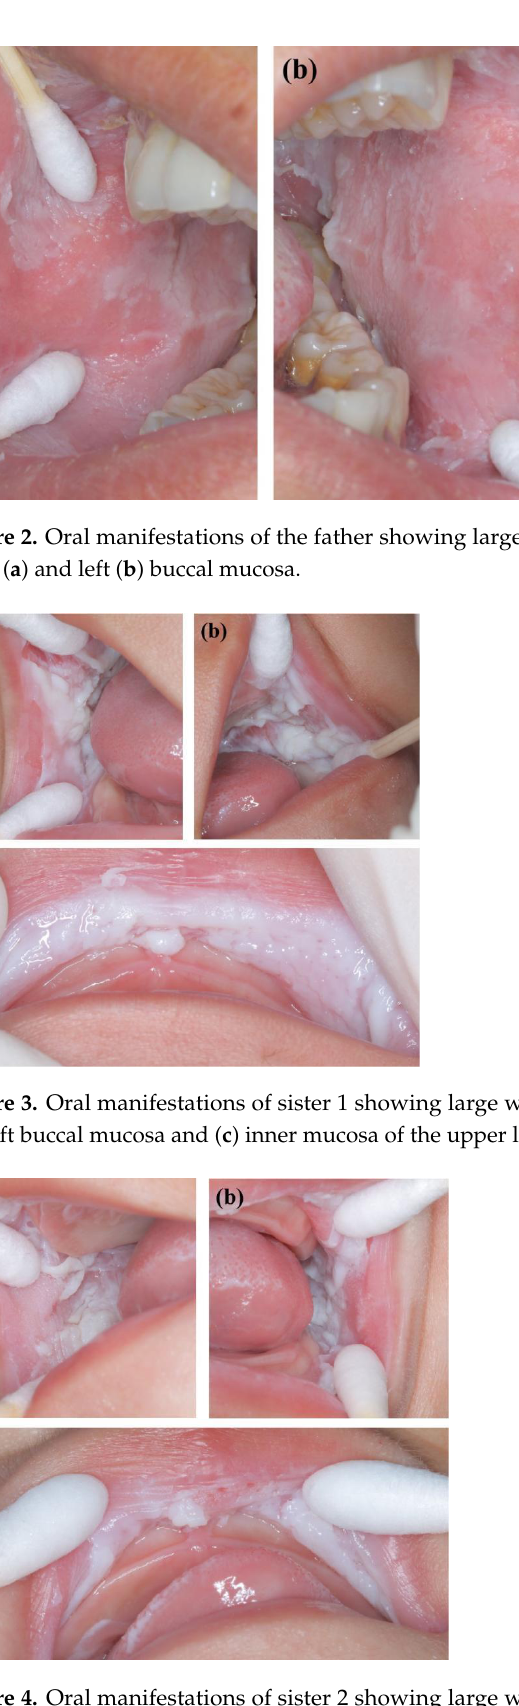
Figure 5. Pedigree of the proband’s family.